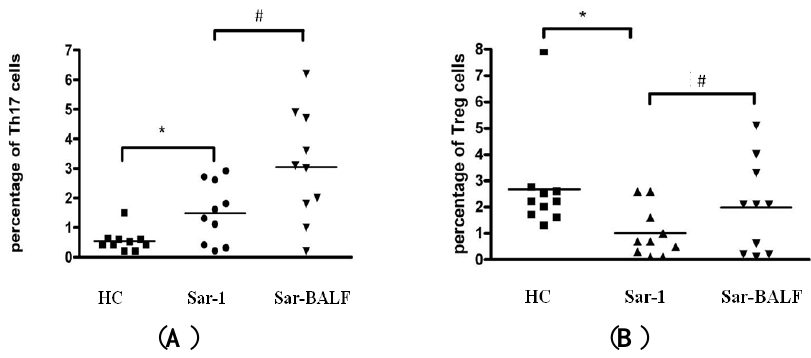
Figure 3. The percentage of Th17 cells ( A ) in the PBMC of HCs and sarcoidosis patients (Sar-1), and in the BALF of sarcoidosis patients (Sar-BALF) ( * p = 0.0139; # p = 0.0016). The percentage of Treg cells ( B ) in the PBMC of HCs and sarcoidosis patients (Sar-1), and in the BALF of sarcoidosis patients (Sar-BALF) ( * p = 0.0286; # p = 0.0346). Each datum point represents an individual patient sample. Median values for each group are represented by the horizontal